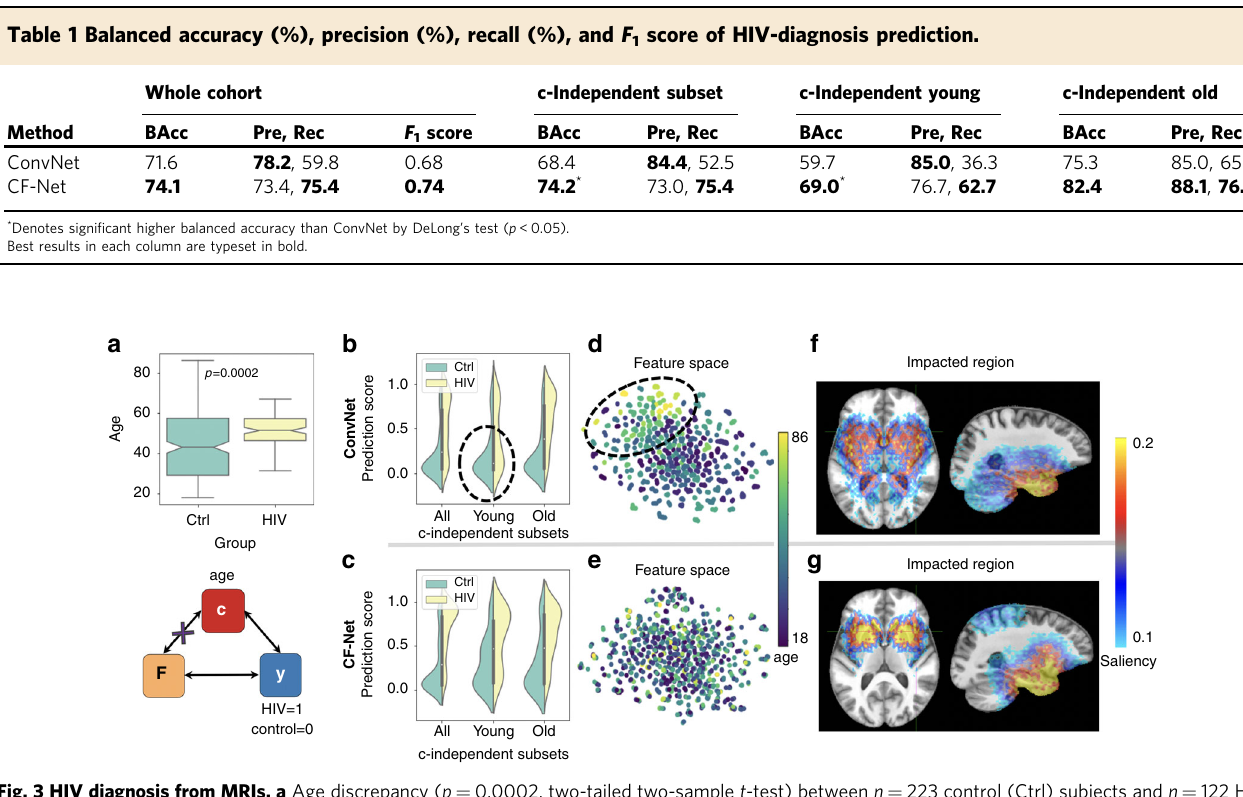
Fig. 3 HIV diagnosis from MRIs. a Age discrepancy ( p = 0.0002, two-tailed two-sample t -test) between n = 223 control (Ctrl) subjects and n = 122 HIV patients resulted in the baseline ConvNet learning the confounding effects ( b , d , f ), which were alleviated by the proposed CF-Net ( c , e , g ). Boxplots are characterized by minimum, fi rst quartile, median, third quartile, and maximum. b , c HIV-prediction scores measured on a subset of n = 122 control and n = 122 HIV subjects with the same age distribution ( c -independent). d , e t-SNE visualization of the feature space learned by the deep-learning models. f , g Saliency maps 33 corresponding to the voxel-level attention (larger attention means more discriminative voxels) by the